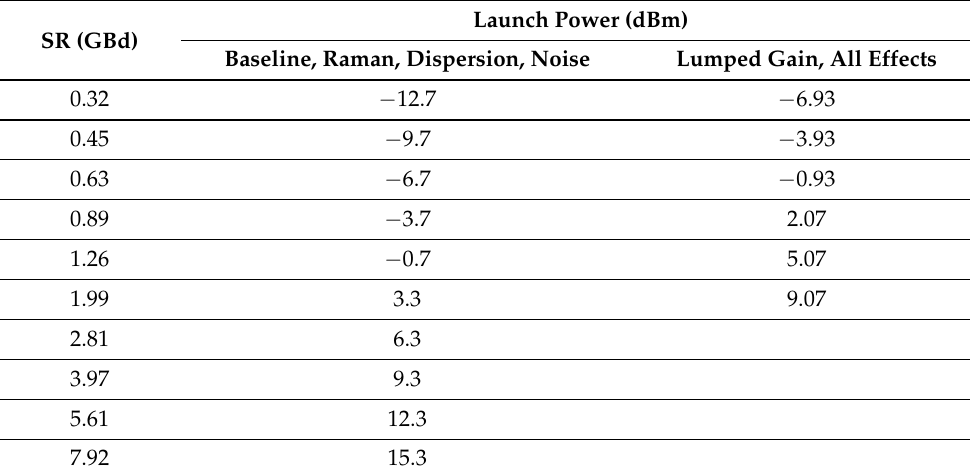
Table 1. Symbol rate of the sistems considered in this study for selected values of the launch power. Launch Power (dBm) SR (GBd) Baseline, Raman, Dispersion, Noise Lumped Gain, All Effects 0.32